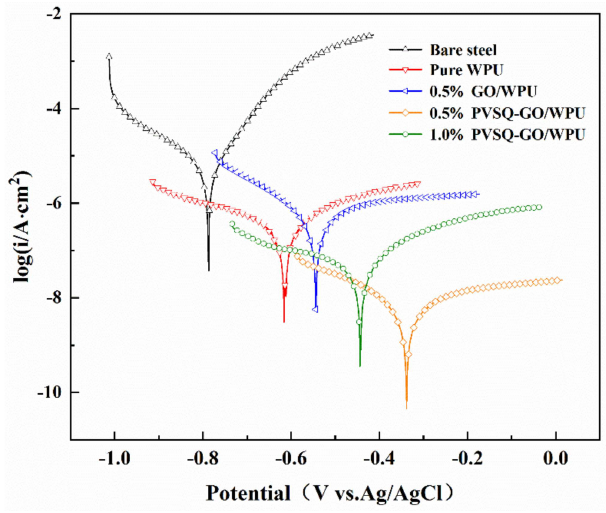
Figure 13. Tafel curves of bare substrate and bare substrate with coatings. Table 2. Potentiodynamic polarization parameter values for coated Q235